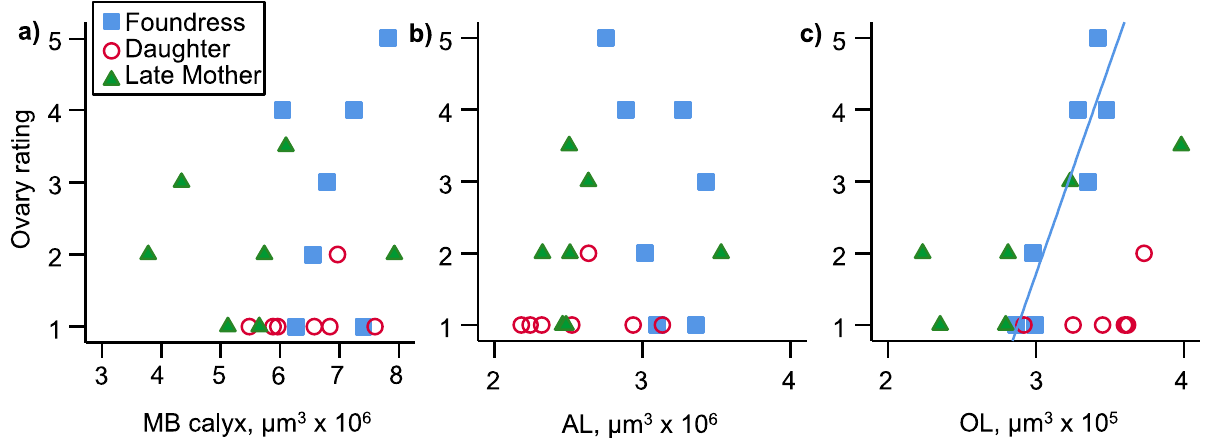
Figure 5. Ovary development plotted against the volume of the MB calyx ( a ), AL ( b ), and OL ( c ). In all panels, late mothers are represented by green filled triangles, foundresses by blue filled squares, and newly emerged daughters by open red circles. Regression lines are shown for statistically significant within-group relationships (Spearman’s rank correlation) only, and represent linear regressions (N = 7 for each